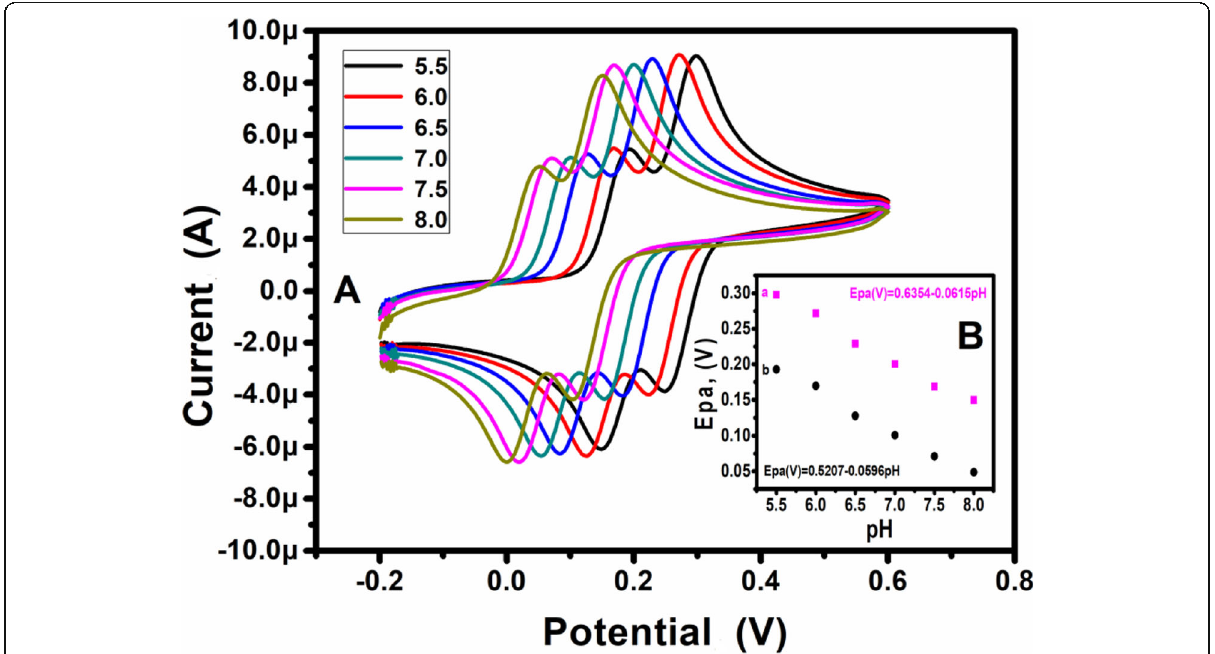
Fig. 6 a CVs obtained for 40.0 μ M CC and HQ binary mixture at ALR/GCE of different pH (5.5 to 8.0) at 0.05 Vs − 1 scan rate. b Influence of pH on anodic peak potential of